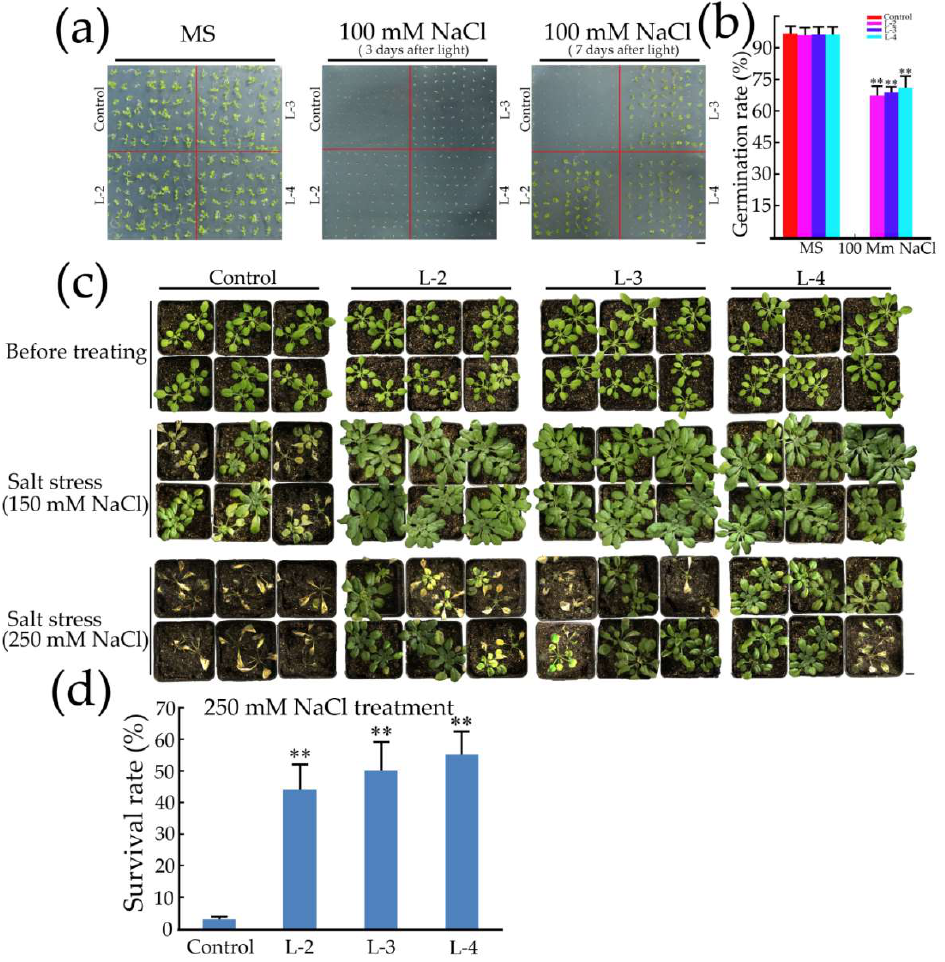
Figure 5. Comparative analysis of seed germination and seedling survival rate under salt stress among control (Col-0) and transgenic Arabidopsis plants. ( a ) Germination status of control, L-2, L-3 and L-4 seeds in MS plates, with or without supplementation with 100 mM NaCl, 3 or 7 days after exposure to light. Bar = 1 cm. ( b ) Germination rate of Col-0, L-2, L-3 and L-4 seeds in MS plates, with or without supplementation with 100 mM NaCl, 3 days after exposure to light. ( c ) The phenotypes of the control and transgenic Arabidopsis plants under normal and different concentrations (150 mM and 250 mM) of NaCl. Four-week-old seedlings grown in soil were assessed. Bar = 1 cm. ( d ) Survival rates of transgenic Arabidopsis plants treated with 250 mM NaCl. Error bars indicate SDs. Statistically significant differences were assessed using Student’s t -test (** p < 0.01).